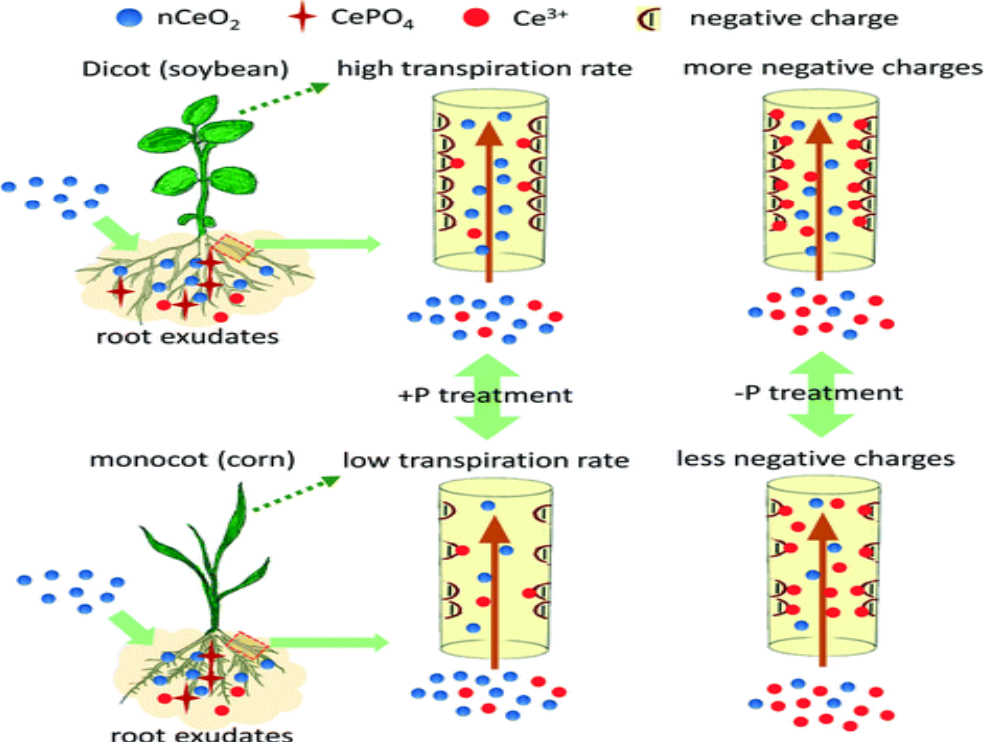
Figure 4. Comparative studies of translocation of cerium oxide nanoparticles and cerium ions on corn (monocot) and soybean (dicot). Reproduced from [81]; Royal Society of Chemistry (open access under Creative Commons Agreement).